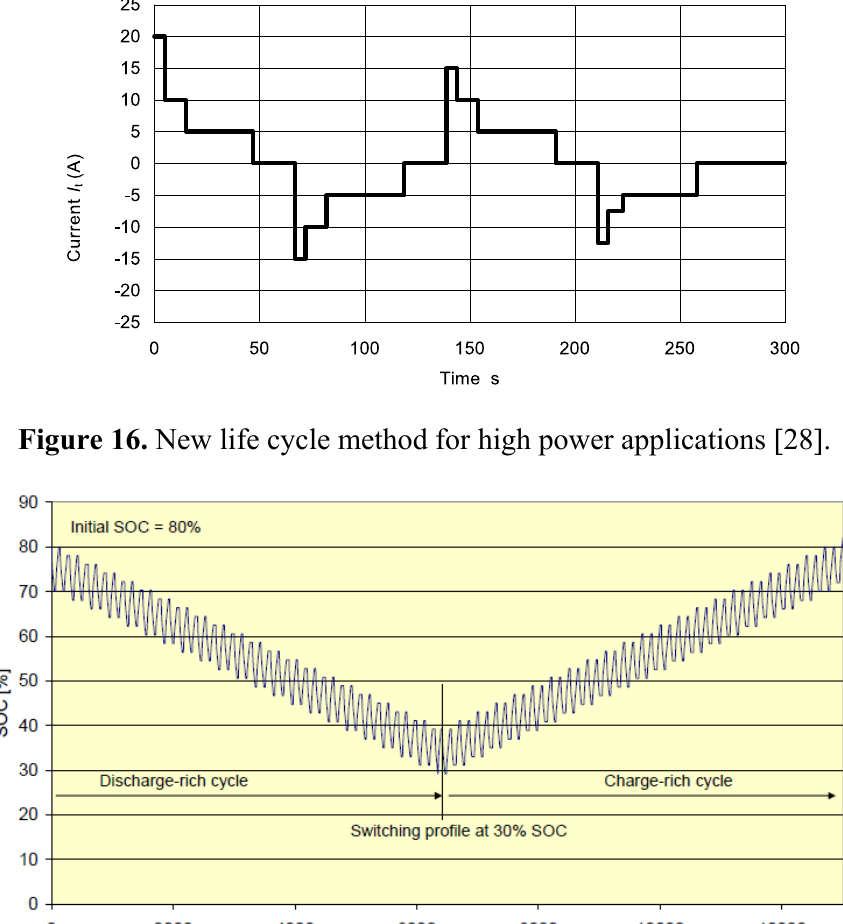
Figure 15. IEC micro-cycle discharge rich profile for battery electric vehicle [ 28 ] .